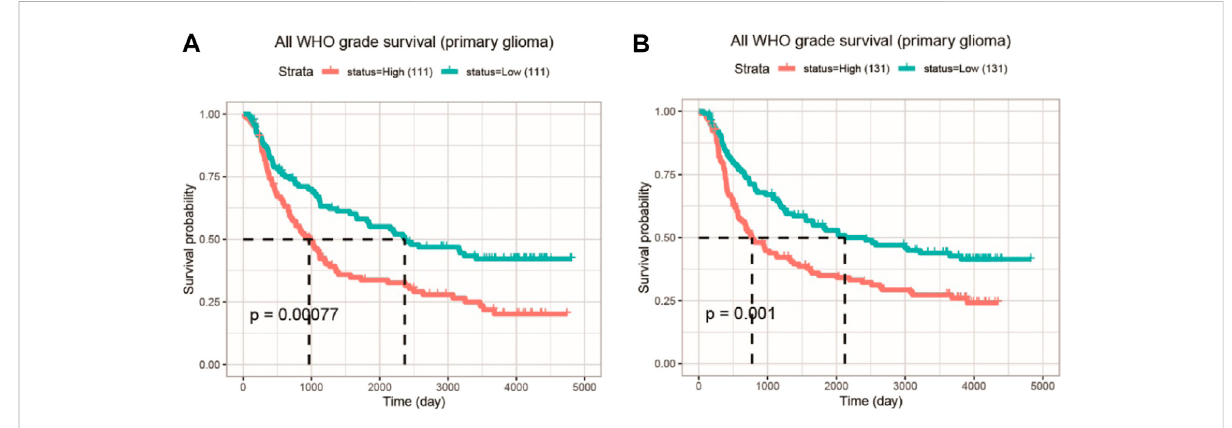
FIGURE 3 The KM survival curve illustrating the expression of COMMD4 in GBM and LGG patients (A) Dataset ID: mRNAseq_325-Primary Glioma (B) Dataset ID: mRNA_array_301-Primary